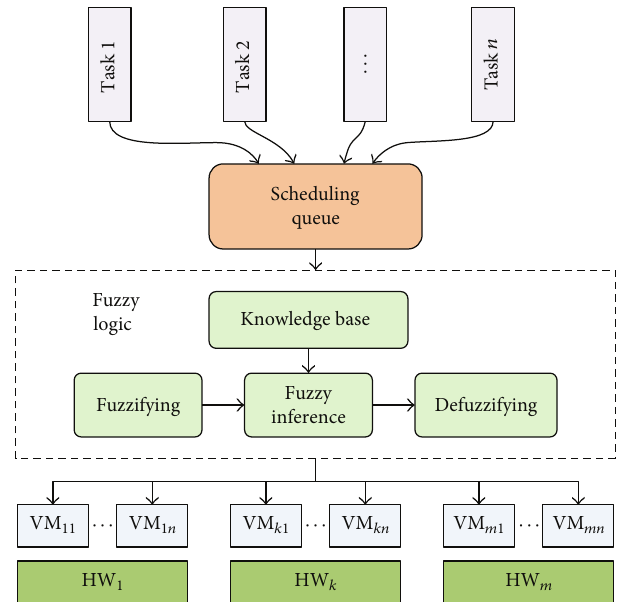
Figure 3: Resource scheduling process based on fuzzy logic.